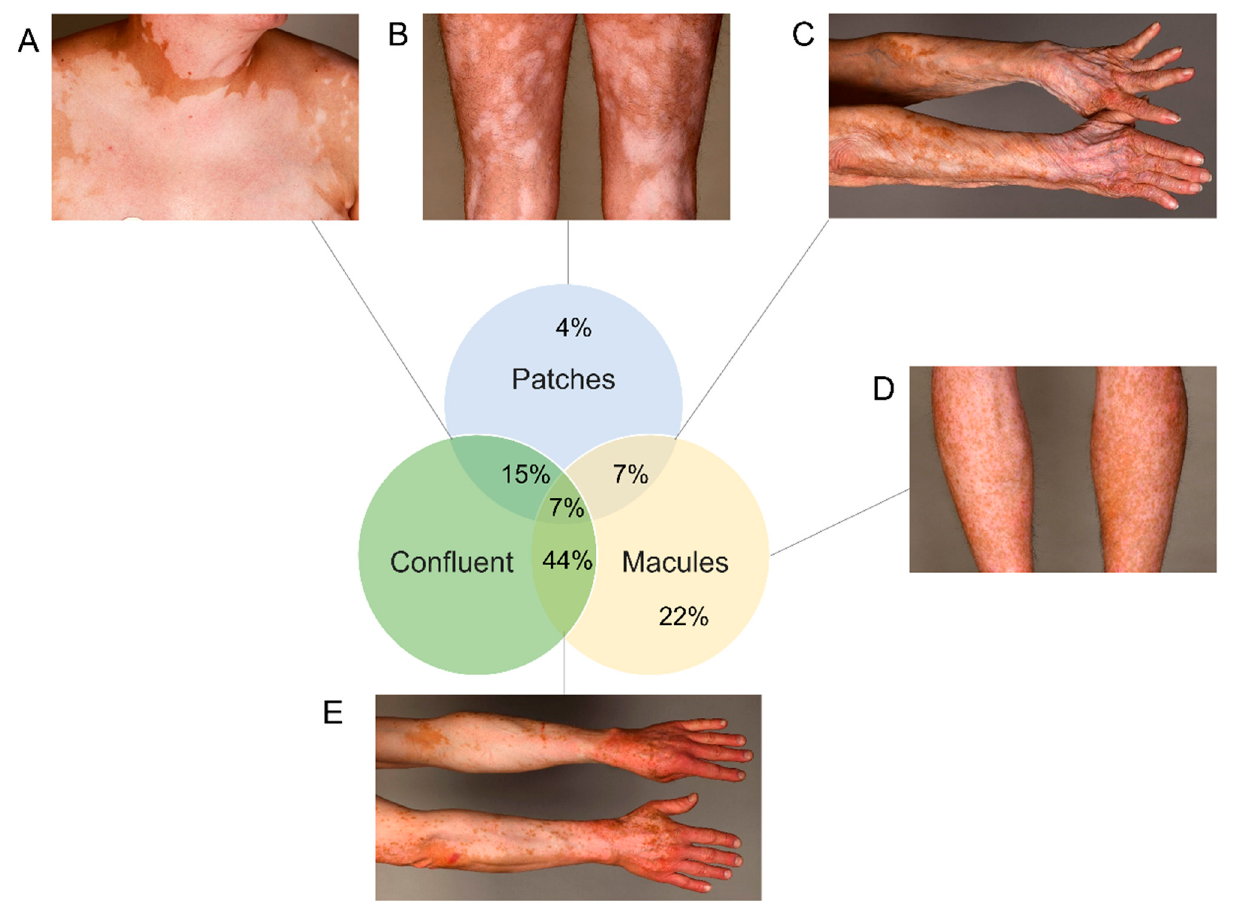
Figure 3. Different patterns in absolute frequencies with examples. ( A ) Confluent big patches. ( B ) Large patch-pattern non-confluent. ( C ) Patches and macules, confluent pattern. ( D ) Small macules, non-confluent. ( E ) Confluent macules (most frequent pattern).